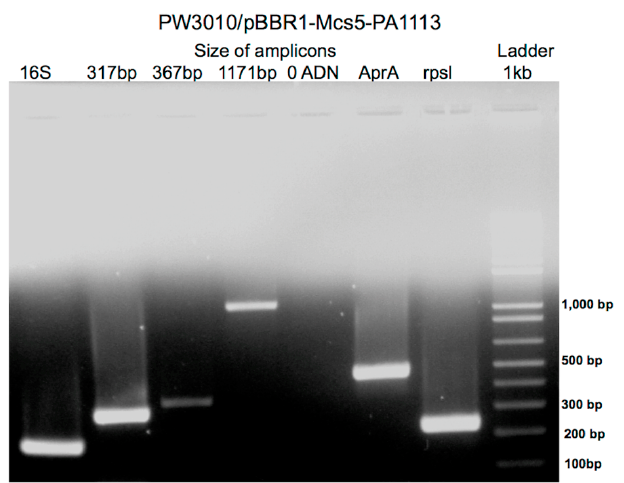
Figure 4. Expression of the PA1113 gene in the mutant PW3010 transformed with the plasmid pBBR1-Mcs5 containing the wild-type gene PA1113. RT-PCR was performed on total RNAs as described in the Materials and Methods section.